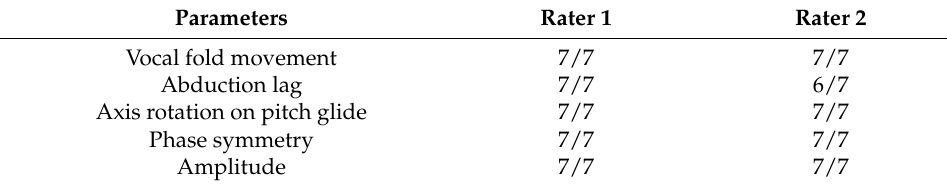
Table 3. Intra-rater reliability (exact agreement in second rating/total repeated videos).